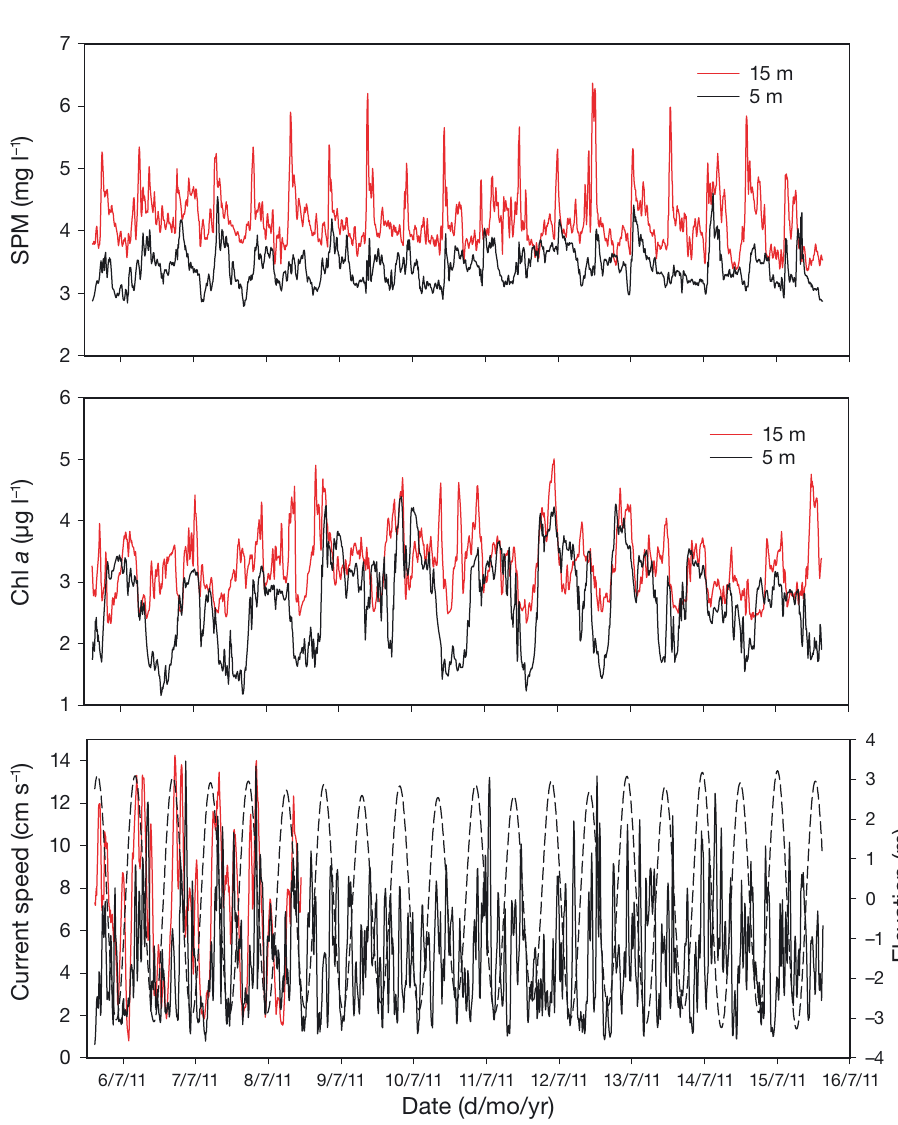
Fig. 3. Suspended particulate matter (SPM) and chlorophyll a (chl a ) concentrations and current speeds, collected at 10 min in- tervals, at the Charlie Cove salmon farm. Data are from 5 and 15 m depths at a single mooring located 20 m from a net-pen (Fig. 1). The dashed line is the predicted tidal elevation. The instrument mooring was 20 m from the nearest salmon